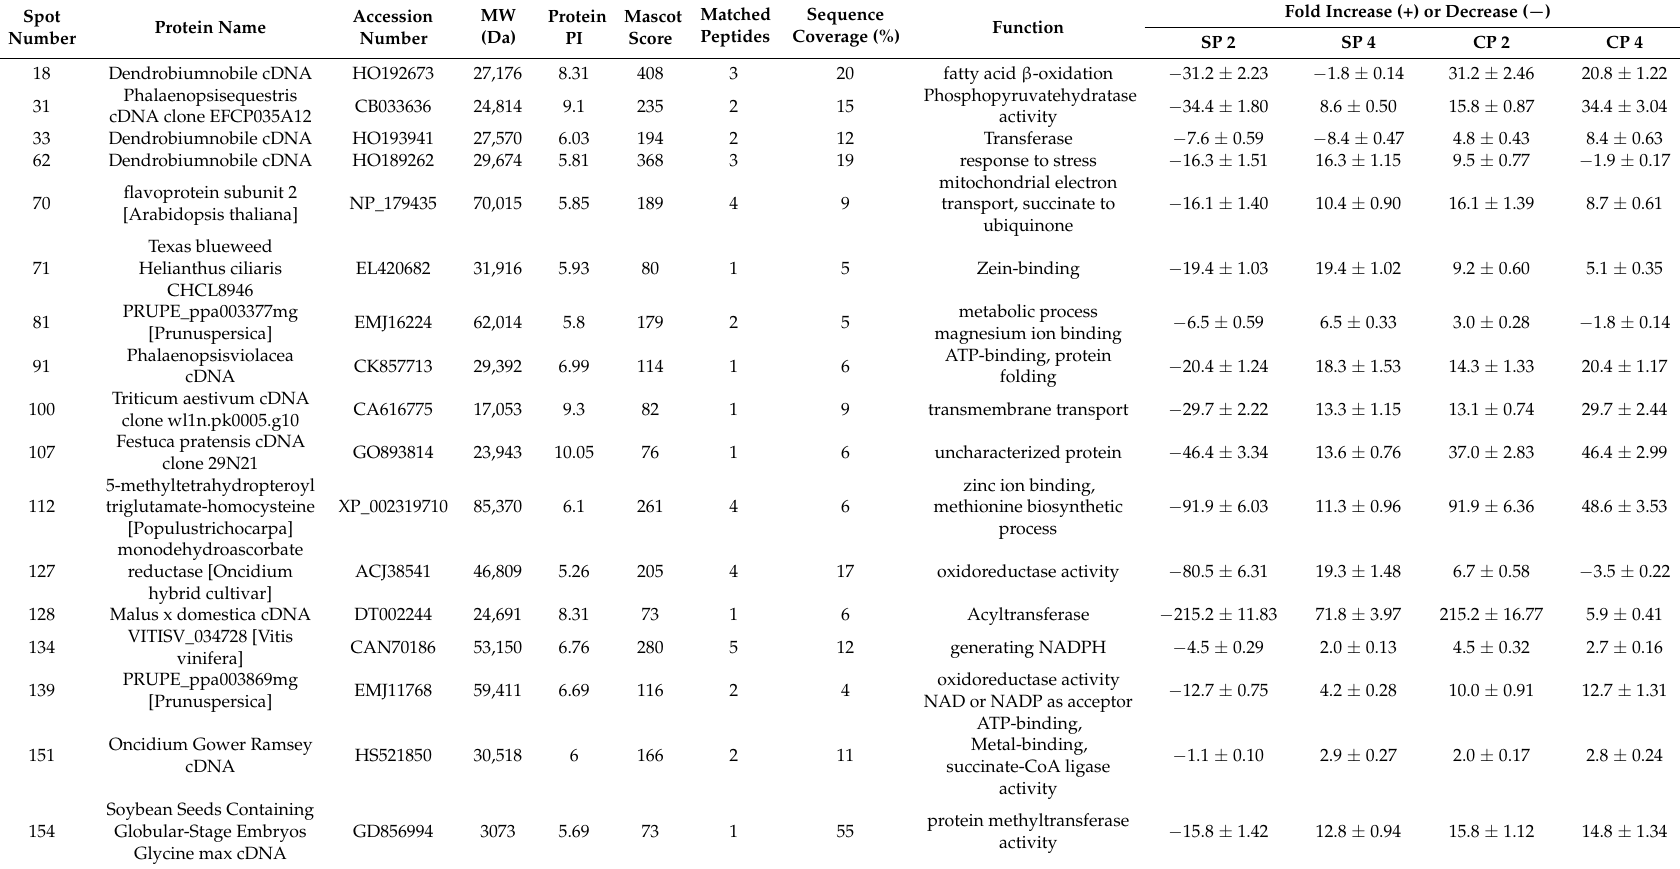
Table 1. Differentially accumulated proteins identified by MS. Protein spot number refers to numbers in Figures 1 and 2. Accession number and Protein name according to the best hit of MASCOT search against NCBInr database and plant EST database. Functional protein classification according to the Uniprot database. Fold increase and decrease were calculated as SP (CP)/control and—control/SP (CP) for up and down-regulated proteins respectively. All fold changes shown are statistically significant ( p < 0.05). PI isoelectric points, MW molecular weight, SP self-pollination, CP